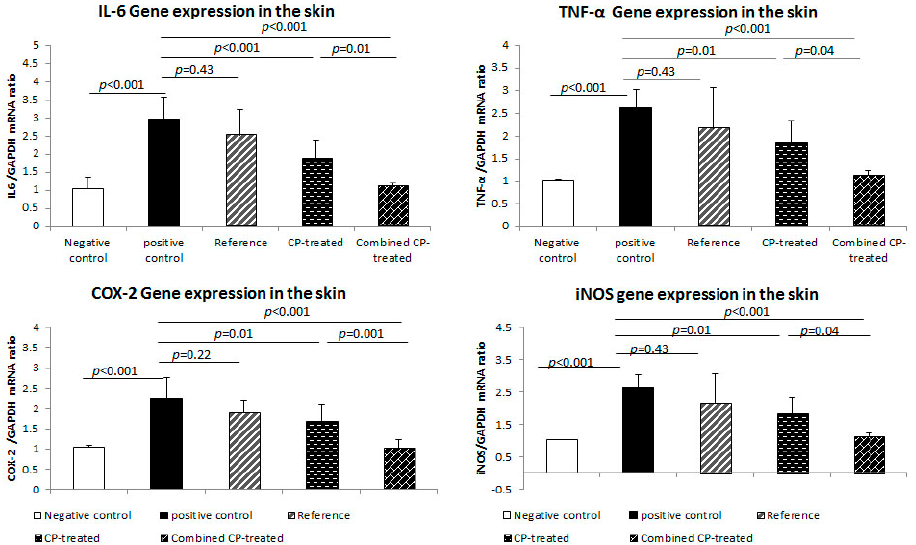
Figure 3. Effect of Cucurbita pepo L. (CP) on the gene expression of the inflammatory cytokines of the study groups. The levels of mRNA of IL-6, TNF- α , COX-2, iNOS were assessed in the skin using qRT-PCR. Data are presented as the mean ± SD, n = 10. One way ANOVA test was used to compare between groups, followed by the Bonferroni post hoc test.